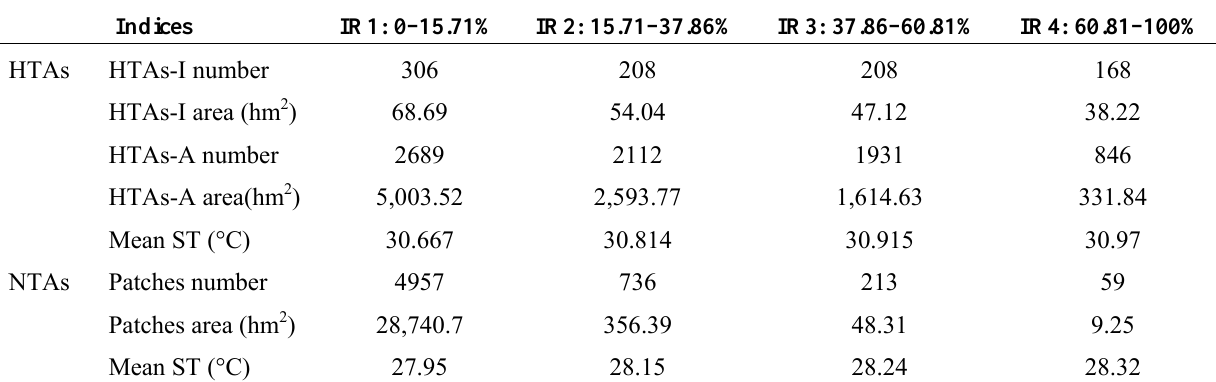
Table 4. IR structure of high temperature